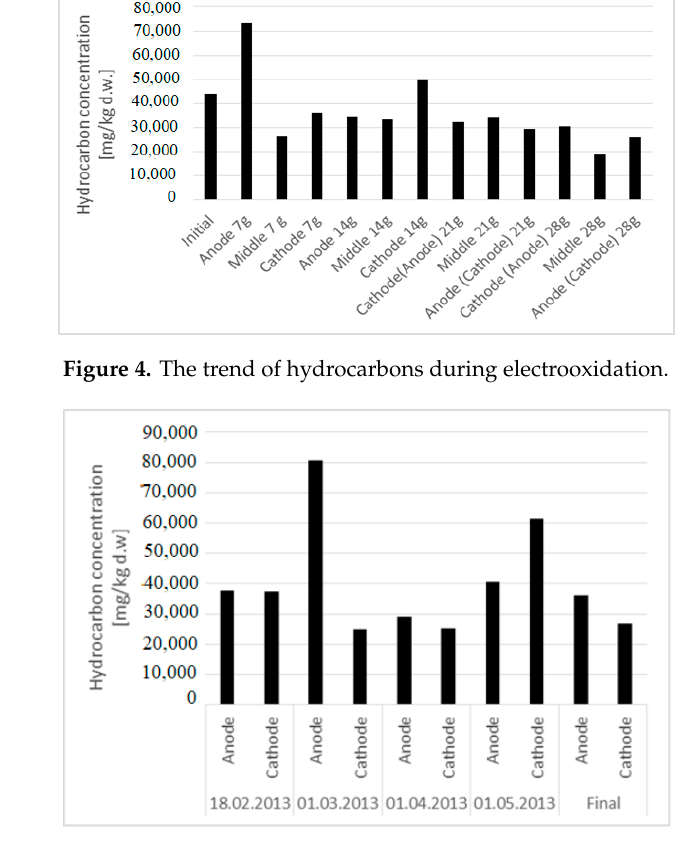
Figure 5. Variation of hydrocarbons during phyto-electroremediation.